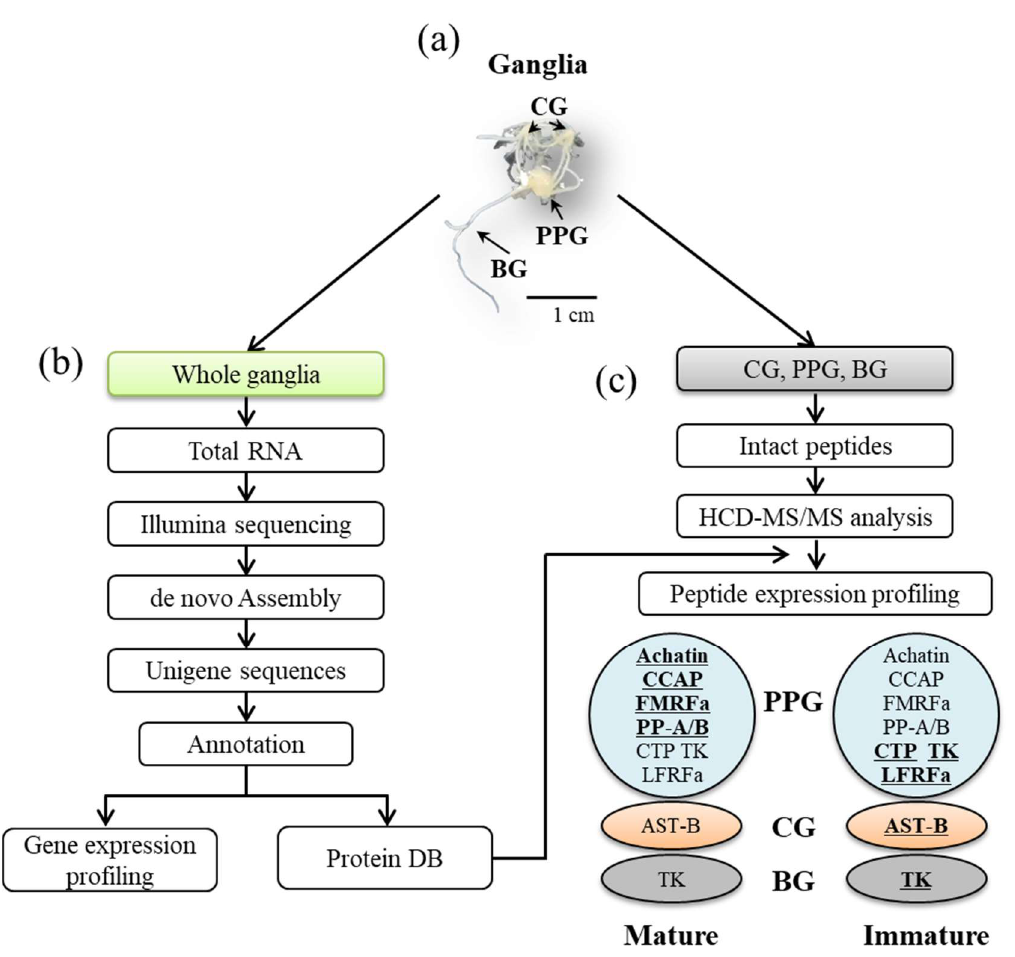
Figure 1. Workflow of transcriptomics and peptidomics experiments to identify neuropeptides of immature and mature female Haliotis discus hannai and a summary of the results in the present study. ( a ) Ganglia of abalone, cerebral ganglion (CG), pleuro-pedal ganglion (PPG), and branchial ganglion (BG); ( b ) Differentially expressed genes (DEGs) between mature and immature stages by transcriptome analysis; and, ( c ) Overview of increased (bold and underlined) or decreased neuropeptides by peptidome analysis.